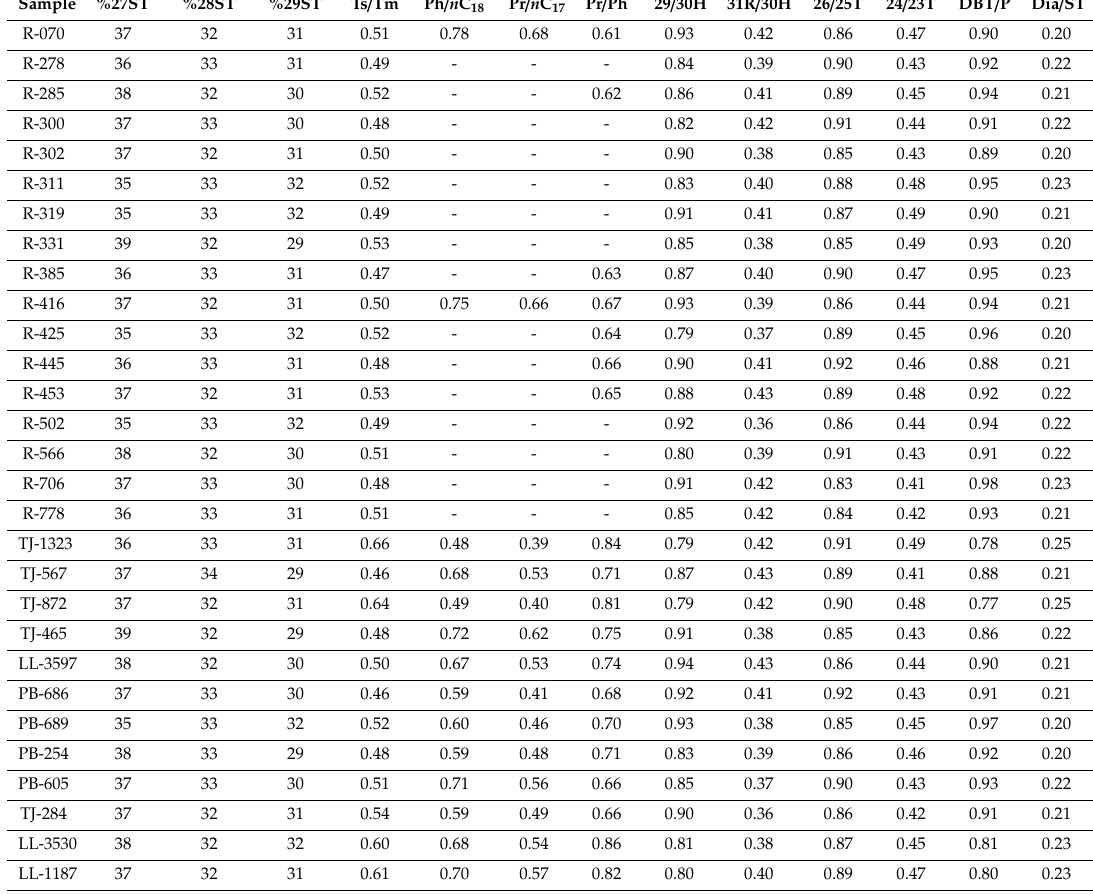
Table 3. Molecular parameters obtained from the aromatic and saturated hydrocarbons of the oils analyzed, which indicate source types and depositional environments.